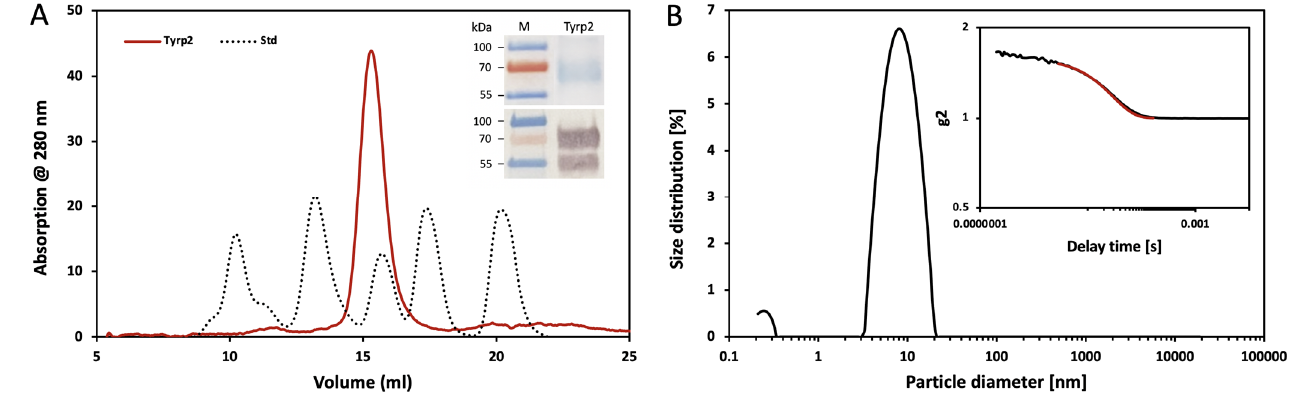
Figure 2. Monomeric stage of Tyrp2 protein. ( A ) Chromatography profile of Tyrp2 for fractions eluted from the Superdex 200 Increase GL 10/300 column (red). The dotted line corresponds to the Bio-Rad GF standards. From the left: thyroglobulin (670 kDa), γ-globulin (158 kDa), ovalbumin (44 kDa), myoglobin (17 kDa), and vitamin B12 (1.3 kDa). Insert shows the SDS-PAGE (top panel) and the Western blot (bottom panel) of Tyrp2. The left line displays the protein ladder marker (M) at 55, 70, and 100 kDa. ( B ) Dynamic light scattering of Tyrp2 protein. Particle diameter distribution by intensity for Tyrp2 at 1 mg/mL measured at 25 °C. Insert shows the correlation function, where g2 is the correlation function intercept. The measured autocorrelation function is black, and the cumulant fit function is red. Table 1. Tyrp2 parameters were determined from the gel-filtration chromatography, dynamic light scattering, and ICP-MS analysis.